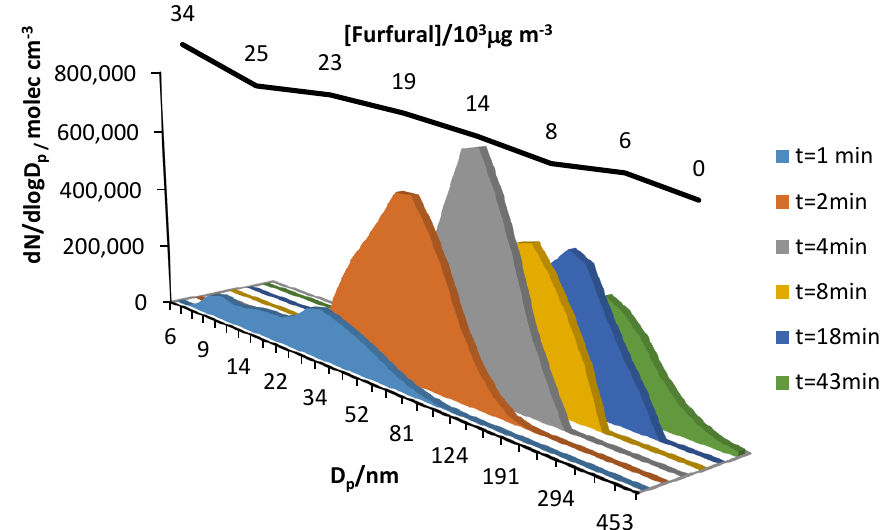
Figure 5. Size distribution of SOA particles formed in the reaction of furfural with chlorine atoms at different times, t = 1 min, t = 2 min, t = 4 min, t = 8 min, t = 18 min, t = 43 min. Variation of furfural concentration during the reaction. Solid line .